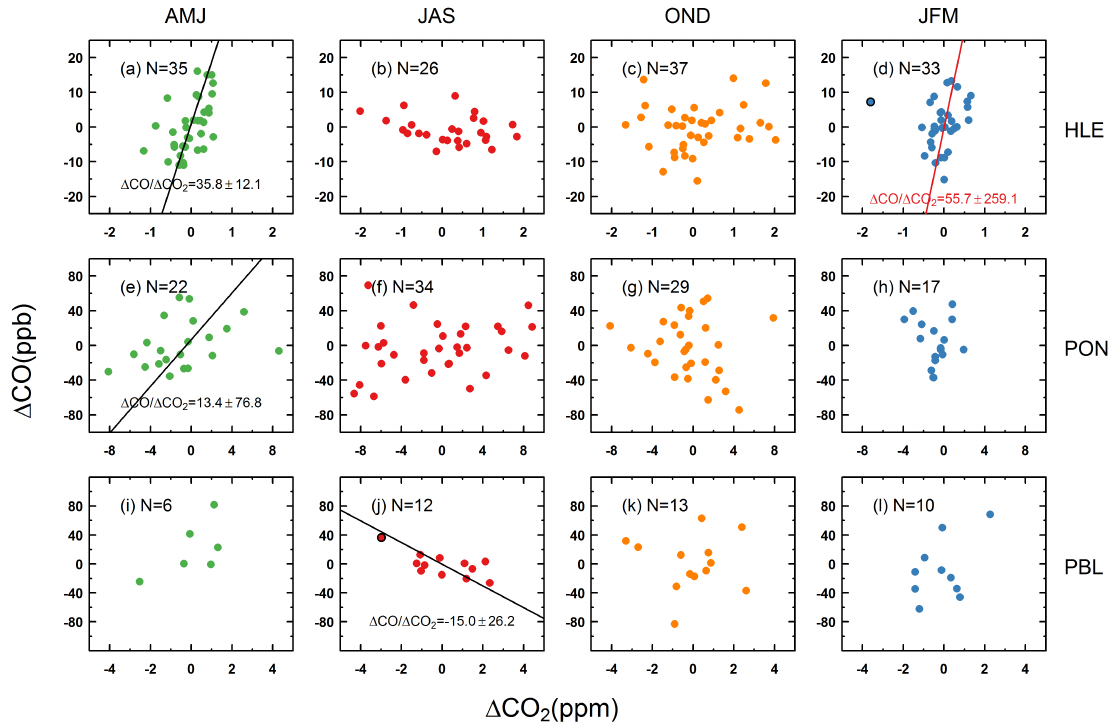
Figure 16. The relationships between (cid:49) CO and (cid:49) CO 2 at HLE (a–d) , PON (e–h) , and PBL (i–l) for April–June (AMJ), July–September (JAS), October–December (OND), and January–March (JFM). For each panel, (cid:49) CO and (cid:49) CO 2 are estimated as residuals from smoothed curves. The (cid:49) CO /(cid:49) CO 2 ratio is the slope of the fitting line from the orthogonal distance regression, with the SD calculated from 1000 bootstrap replications. For (cid:49) CO and (cid:49) CO 2 values that are not significantly correlated, the fitting line is usually not